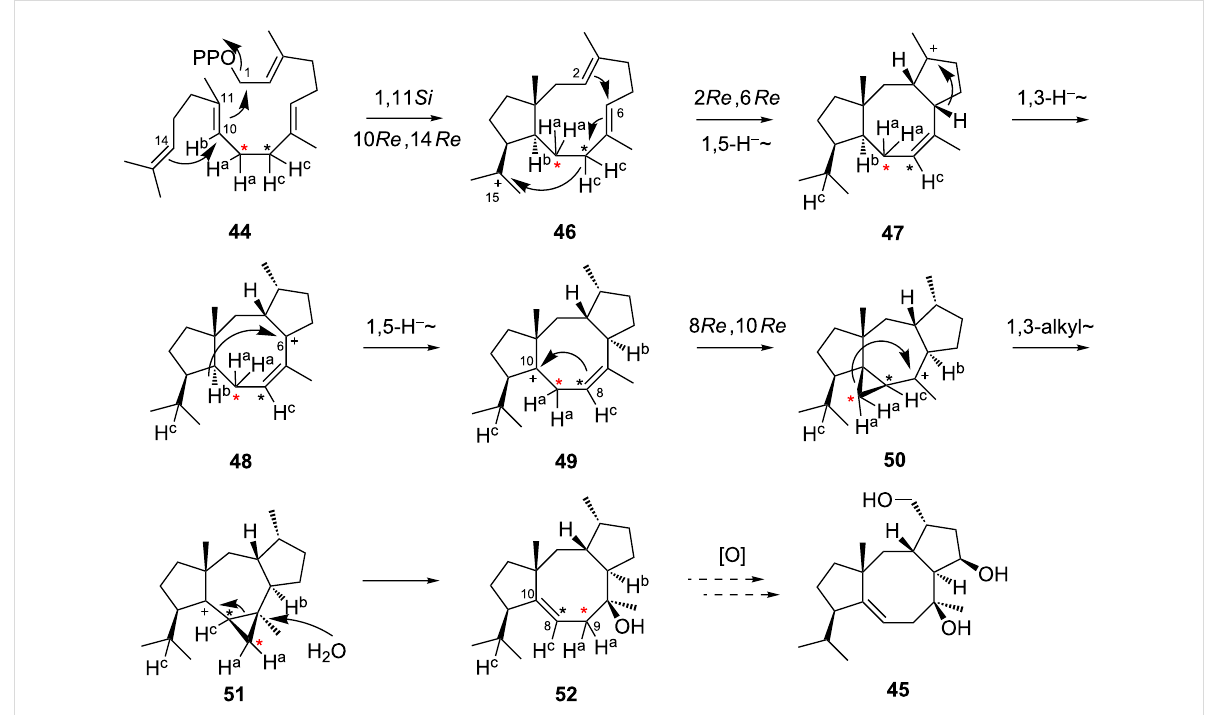
Scheme 9: Proposed mechanism of the cyclooctat-9-en-7-ol ( 52 ) biosynthesis catalysed by CotB2. Annotated hydrogen atoms (a–c) were investi- gated by deuterium labeling. Asterisks are used to follow the rearrangement of C-8 and C-9 (carbon numbers as for